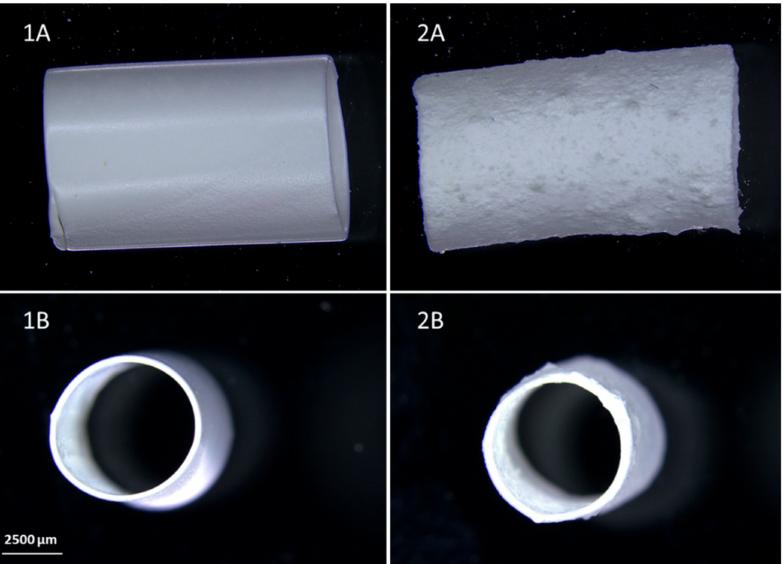
Figure 9. Comparison of the macroscopic images of samples ( A ) and their cross-sections ( B ), PU C45D ( 1 ), PU C45D_10%PVA ( 2 ); scale bar: 2500 µ m.